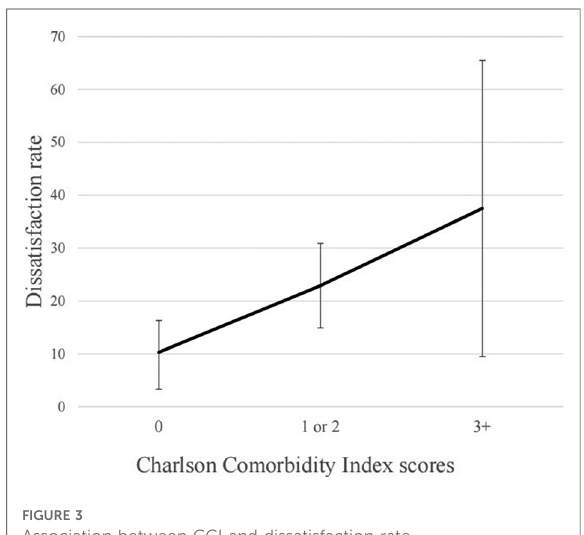
FIGURE 3 Association between CCI and dissatisfaction